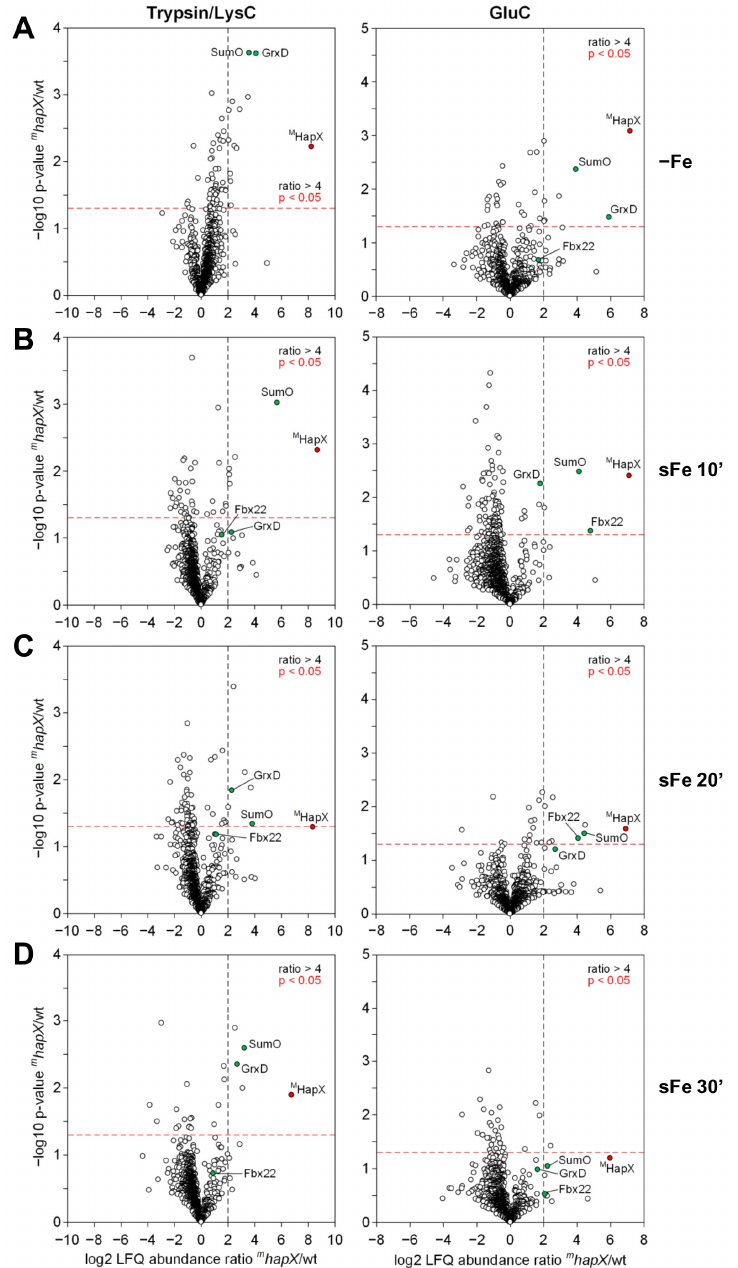
4 Figure 4. HapX physically interacts with Fbx22 and SumO during the adaptation from iron- depleted to iron-replete conditions. ( A – D ). Volcano-plot visualization of specifically enriched proteins interacting with M HapX. Absolute label-free quantification (LFQ) abundances of proteins were determined by nLC-MS/MS analysis after Myc-Trap affinity purification from A. fumigatus m hapX and plotted against LFQ abundances in wild-type eluates. Samples were obtained growing the strains at 37 ◦ C in AMM − Fe ( A ) and sFe 10 ( B ), 20 ( C ) and 30 ( D ) min after the iron shift. Each dot represents the enrichment of a given protein vs. its reproducibility in three biological replicates. Specifically co-purified proteins are indicated by green dots. The bait, M HapX, is marked as a red